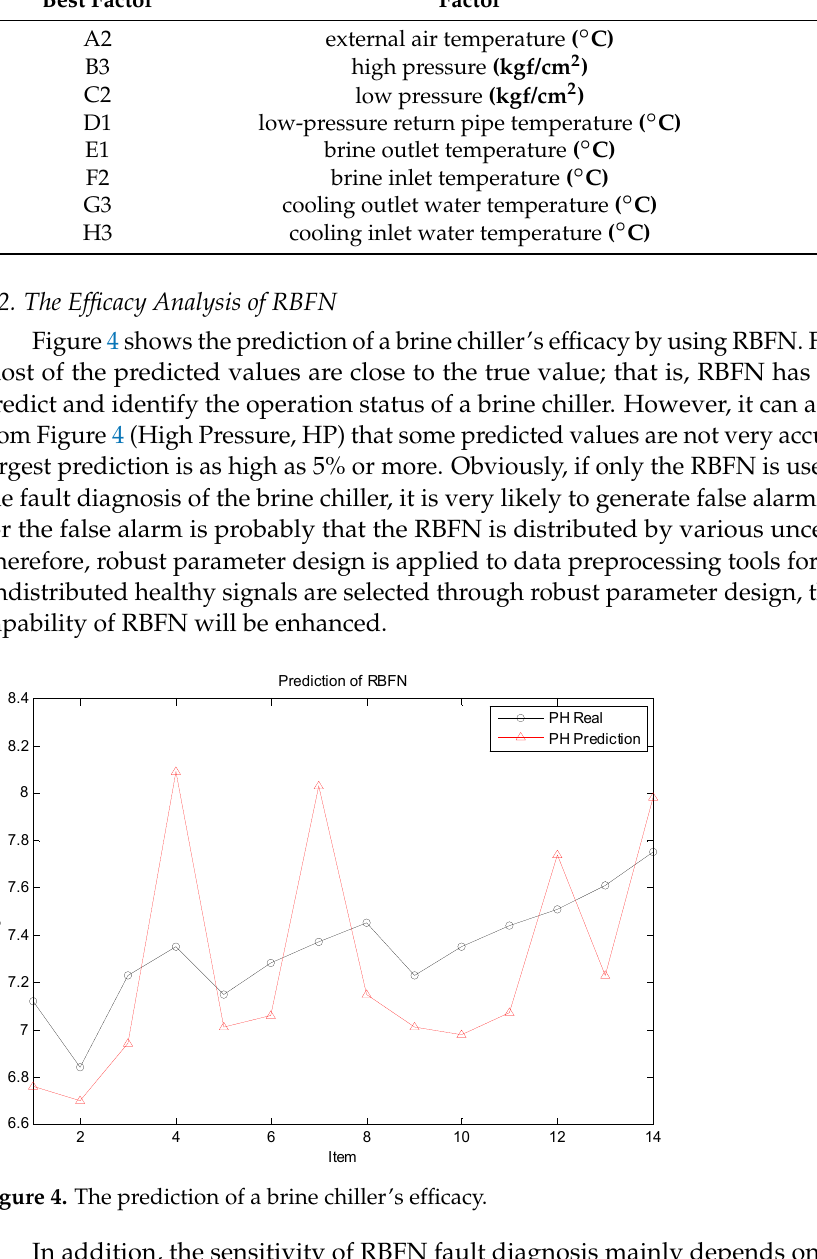
Figure 5. The variance curve of brine inlet water temperature T1 diagnosis efficiency test.